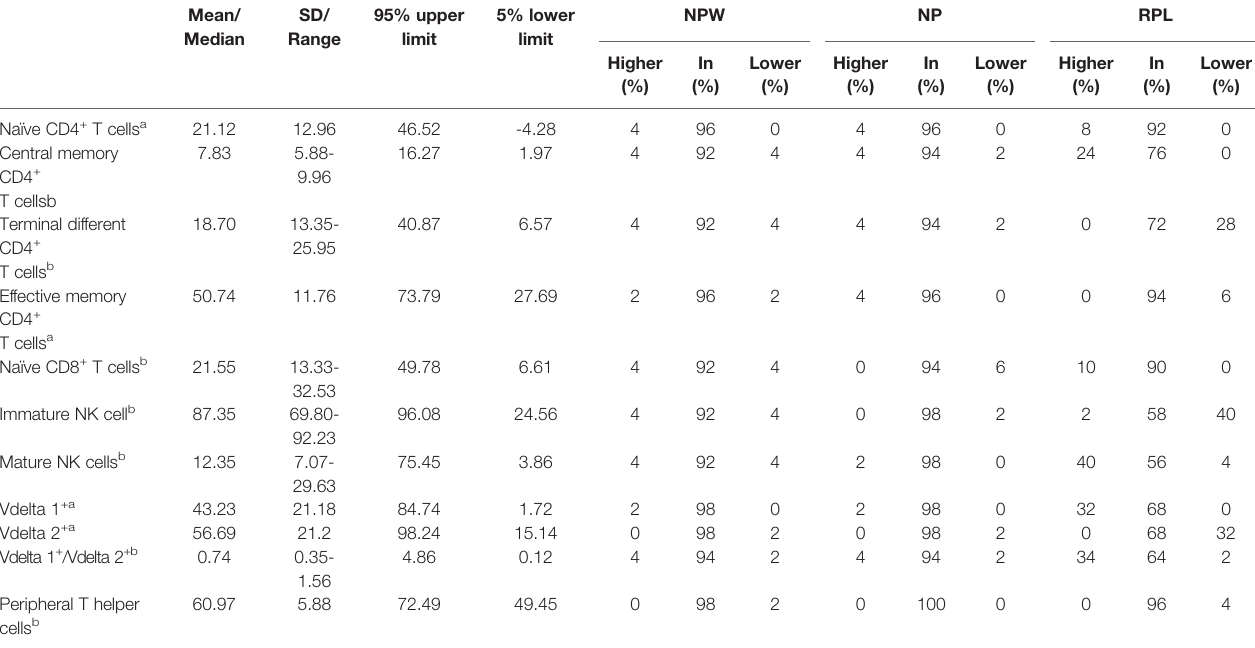
a mean/SD; b median/range.